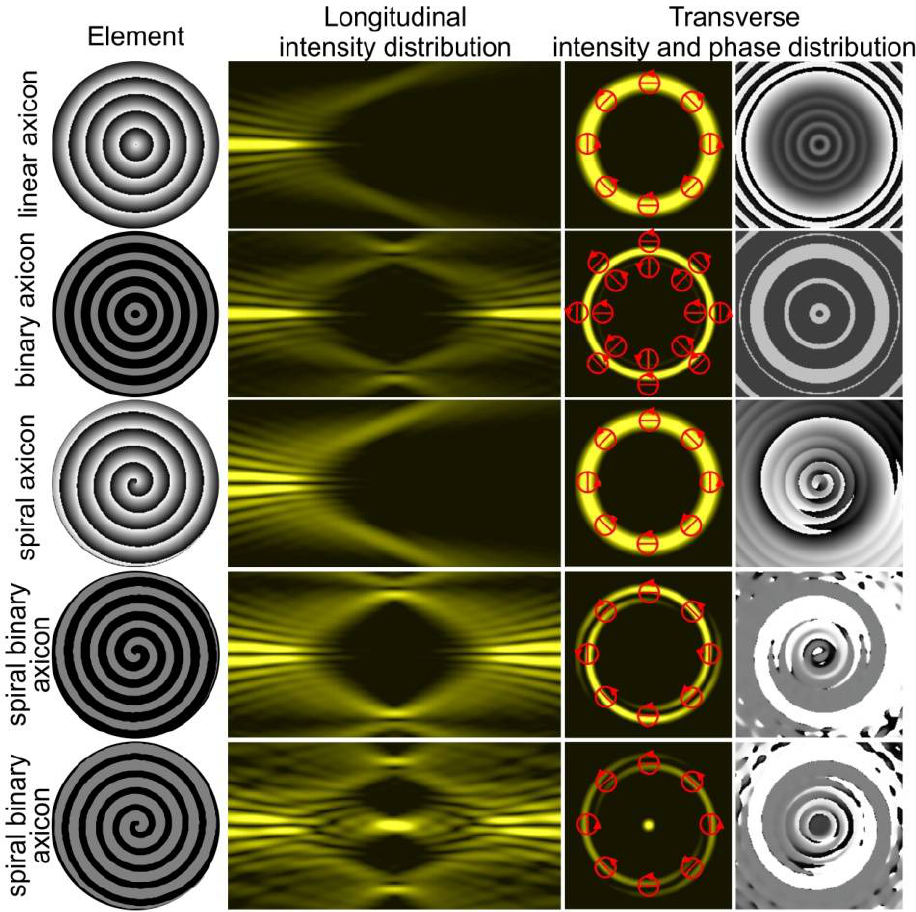
Figure 2. Examples of single vector optical bottle beams generated using different axicons illuminated by a circularly polarized Gaussian beam.